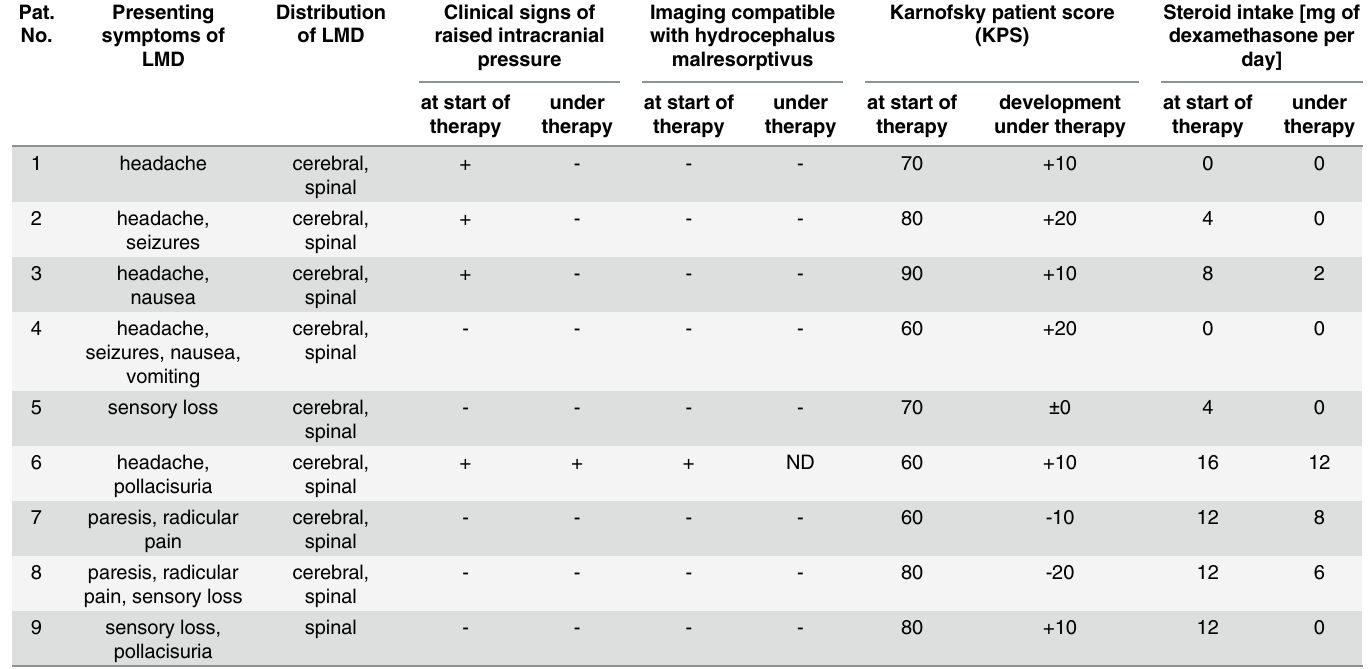
Table 3. Clinical